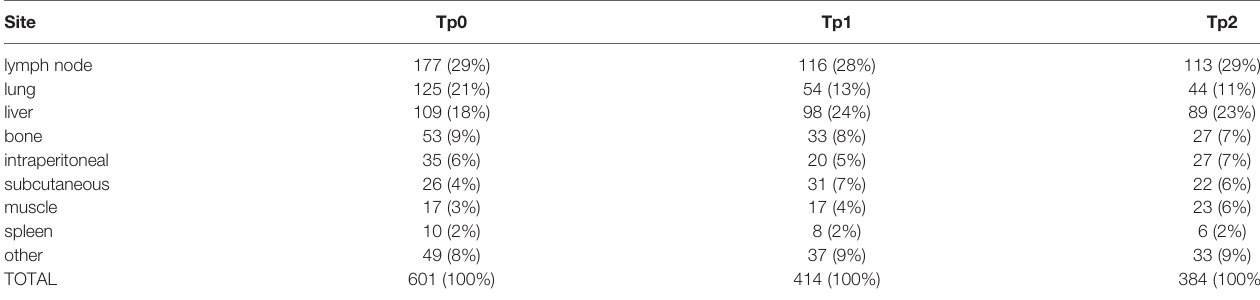
TABLE 2 | Metastases locations among all patients during follow-up. “ Other ” include: retroperitoneal, adrenal gland, heart, throat, orbits and lesions with ambiguous anatomical localisation. Site